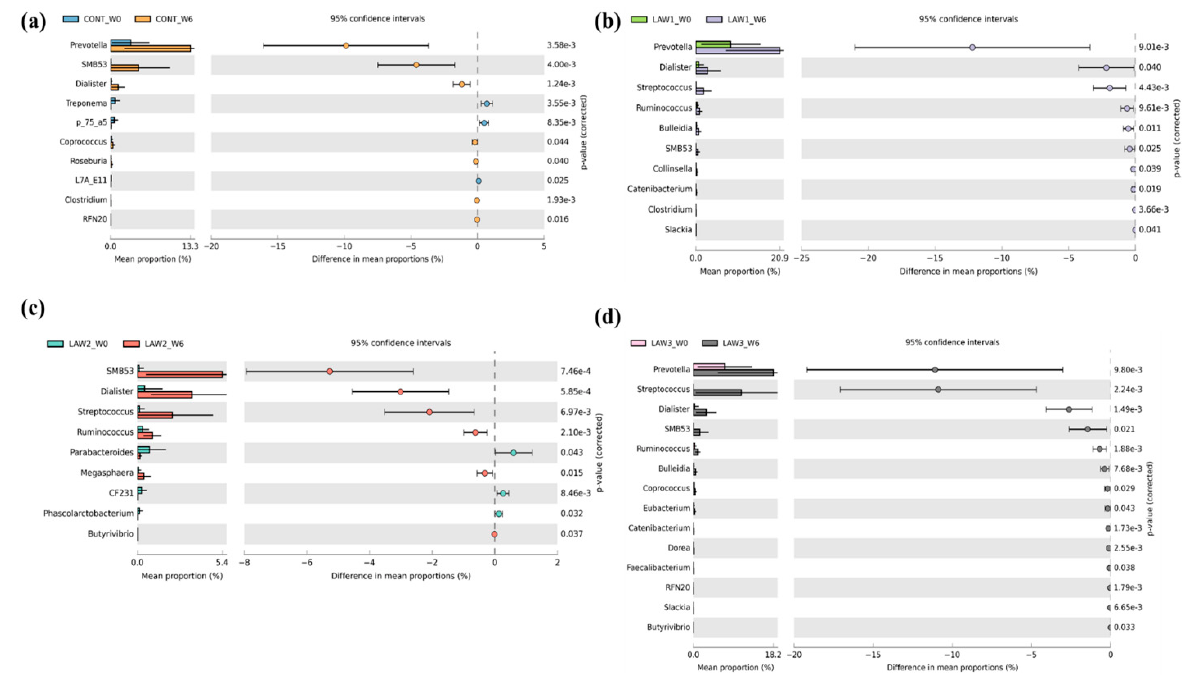
Figure 6. Extended error plots identifying significantly different taxa at the genus level associated with Lawsonia intracellularis vaccination. Significant differential abundance of phyla between week 0 (W0) and week 6 (W6) for each of the treatment groups ( a ) CONT, ( b ) LAW1, ( c ) LAW2, and ( d ) LAW3 are illustrated. Corrected p- Values are shown at the right. Statistical significance is measured using a two-sided Welch’s t-test and a p < 0.05 is considered significant.